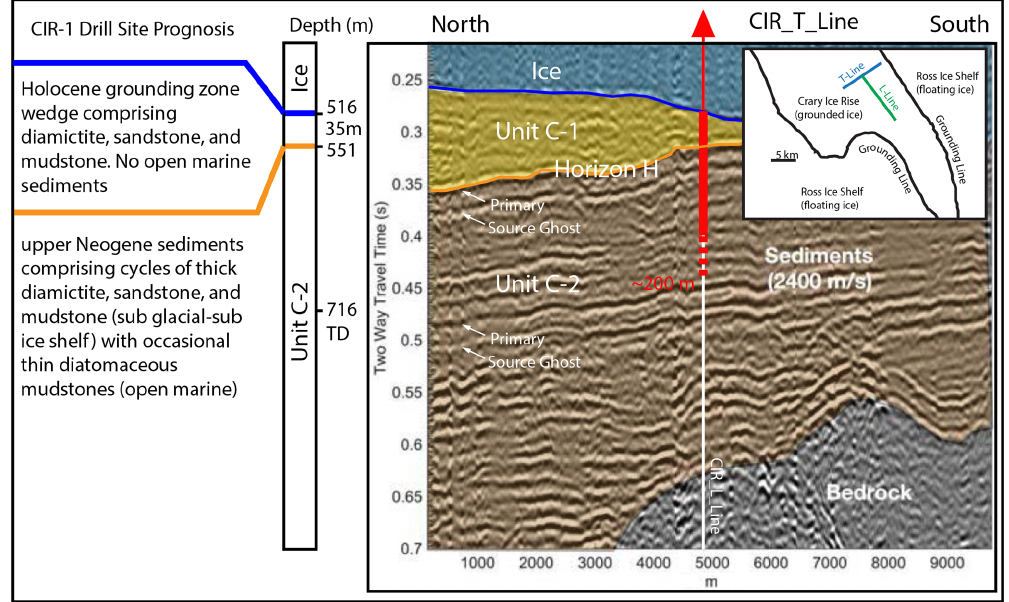
Figure 3. Seismic line CIR_T. The CIR-1 drill site is located on the crossing point with line CIR_L (inset). Drilling prognosis on the left with estimated depths from the surface and a brief description of stratigraphic intervals. The thick red line shows the 200m drilling target